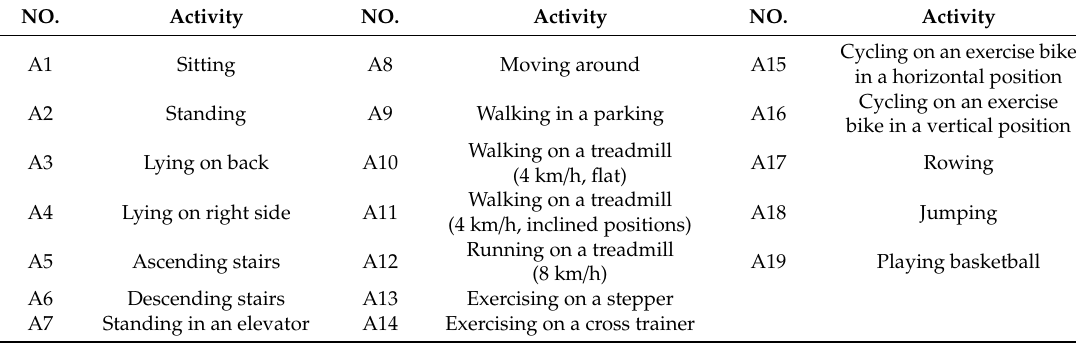
Table 3. The kinds of activities in the